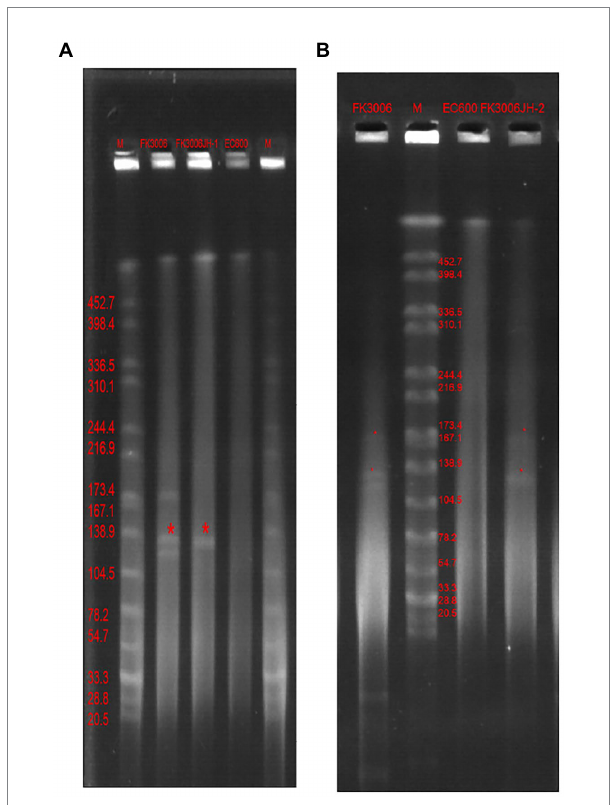
FIGURE 2 S1-PFGE profiles of FK3006, its transconjugants and E.coli 600 Lane marker was X baI digested genomic DNA from Salmonella Braenderup H9812. (A) The transconjugant(FK3006JH-1, the serial dilutions were plated on selective media with ampicillin, 100 μ g/ml) only had one plasmid, with the size of ~139 kb(p3006-11, bla CTX -M-15 ). (B) The transconjugant (FK3006JH-2, the serial dilutions were plated on selective media with dipotassium tellurite, 8 μ g/ml) had two plasmid, with the size of ~139 kb(p3006-11, bla CTX -M-15 ) and ~ 178 kb(p3006-2, iucA